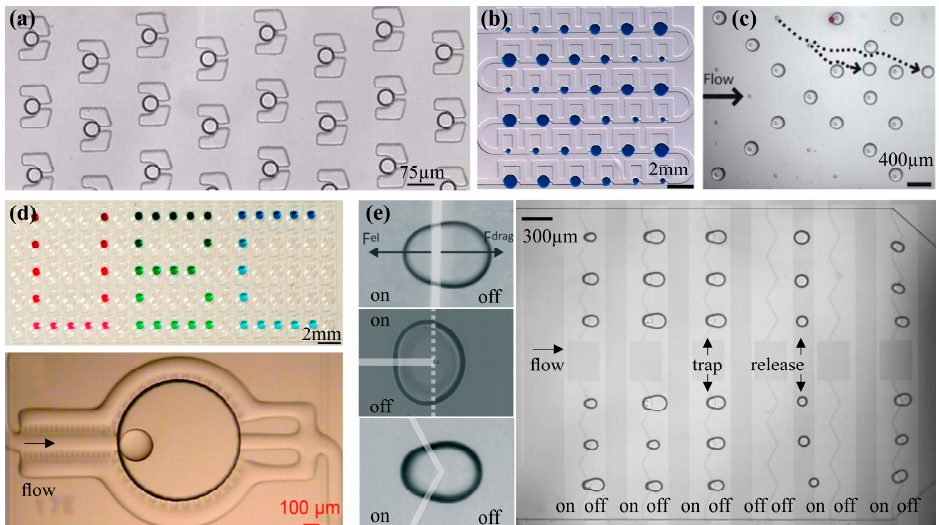
Figure 5. Overview of trapping mechanisms of droplets in oil flow. ( a ) Array of passive geometric traps. Reversing the oil flow releases the droplets. Adapted from [6] with permission of The Royal Society of Chemistry. ( b ) Array of multiple, consecutive microfluidic parking networks of different volume. Reprinted with permission from [7]. Copyright 2014, AIP Publishing LLC. ( c ) Surface energy wells, for trapping droplets and release by laser forcing. Adapted from [5] with permission of The Royal Society of Chemistry. ( d ) Top: Gradients of droplet content created and guided by pneumatic membrane valves to 95 individually addressable traps. Bottom: Magnification of the passive trapping geometry. Adapted with permission from [43]. Copyright 2012, National Academy of Sciences, USA. ( e ) Left: Three different electrode geometries for electrostatic potential wells. Right: Six by six electrostatic potential well arrays for the trapping and release of 36 droplets. Adapted from [26] with permission of The Royal Society of Chemistry.